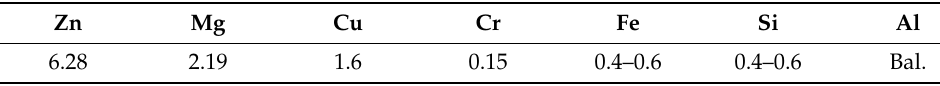
Table 1. Chemical composition of investigated alloys